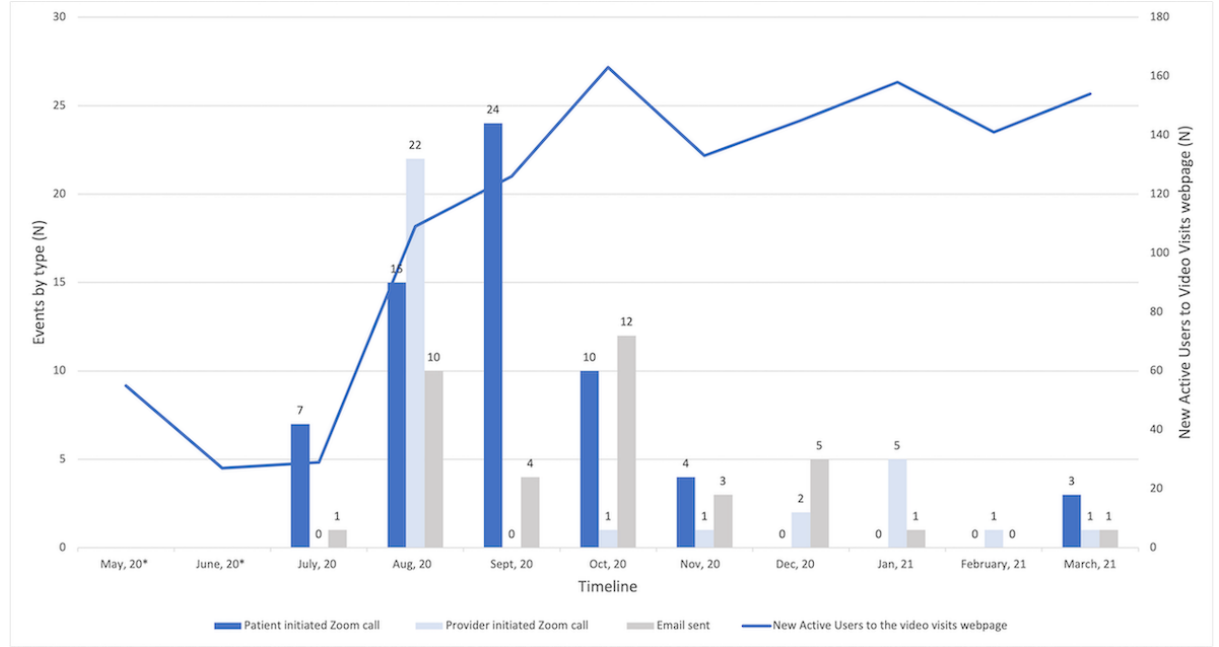
Figure 2. Users of the Video Visits webpage and engagement events (patient- and provider-initiated calls, emails), May 2020-March 2021, San Diego, CA. *The number of users of the Video Visits website was determined from the internal server data for May-June 2020 and from Google Analytics